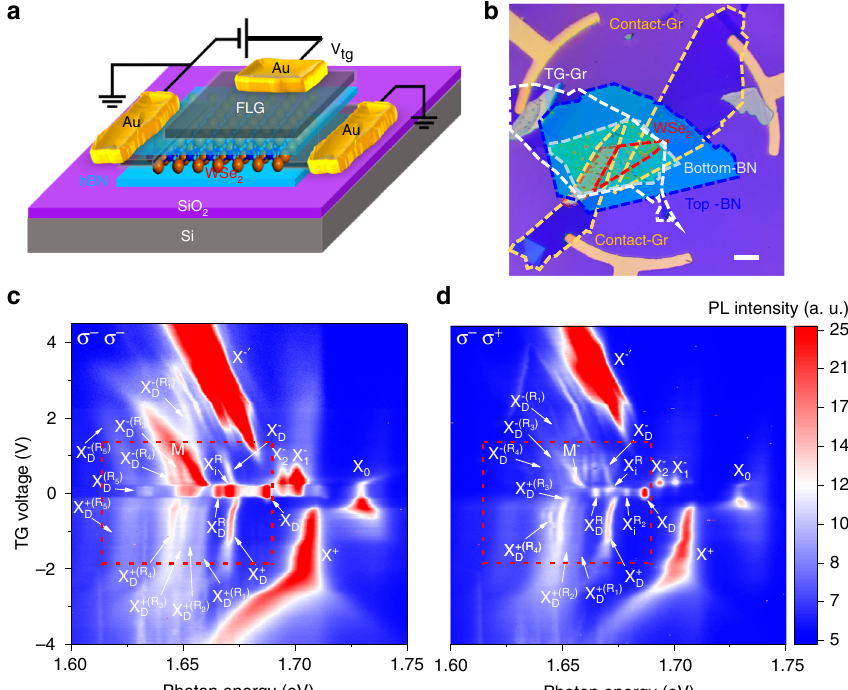
Fig. 1 PL spectra of BN encapsulated monolayer WSe 2 at 4.2 K. a Schematic of the h-BN encapsulated monolayer WSe 2 device. b Optical microscope image of the device. The fl akes of few-layer h-BN, few-layer graphene, and monolayer WSe 2 are outlined with different colors. The scale bar is 20 µ m. c , d PL spectra of the monolayer WSe 2 as a function of top gate voltage for the σ − σ − con fi guration ( σ − excitation and σ − detection) and the σ − σ + con fi guration ( σ − excitation and σ + detection), respectively, with a CW laser excitation centered at 1.879 eV and an excitation power of 50 µ W. The color Þ , intravalley trion ð X (cid:1) Þ , and the represents the PL intensity. Besides the bright exciton (X 0 ), dark exciton (X D ), positive trion (X + ), intervalley trion ð X (cid:1) 1 2 Þ , negative dark trion ð X (cid:1) Þ , intervalley exciton – phonon replica ( X R Þ , there recently discovered positive dark trion ð X þ ), and dark exciton – phonon replica ð X R D D i D are additional emerging excitonic states that are labeled as X þð R 1 Þ D doping regions. In addition, X R 2 emerges in the σ − σ + con fi i